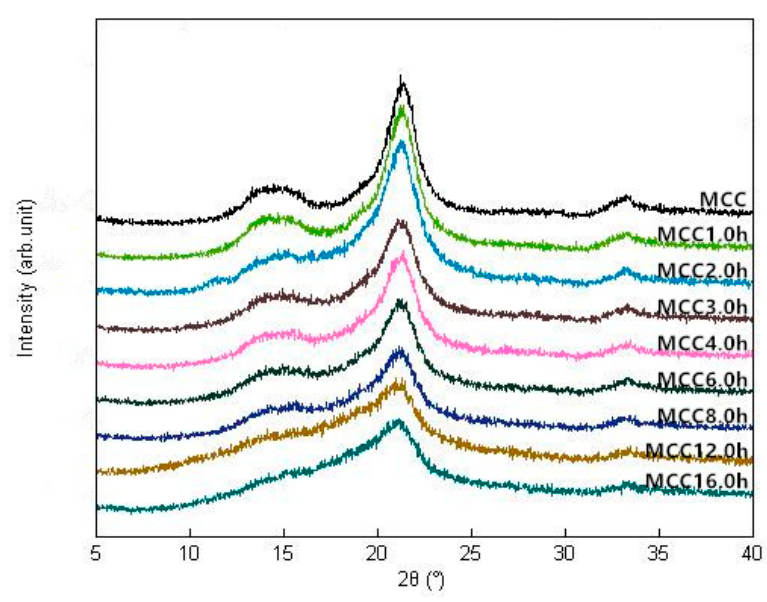
Figure 2. XRD patterns of MCC samples with different ball milling time.